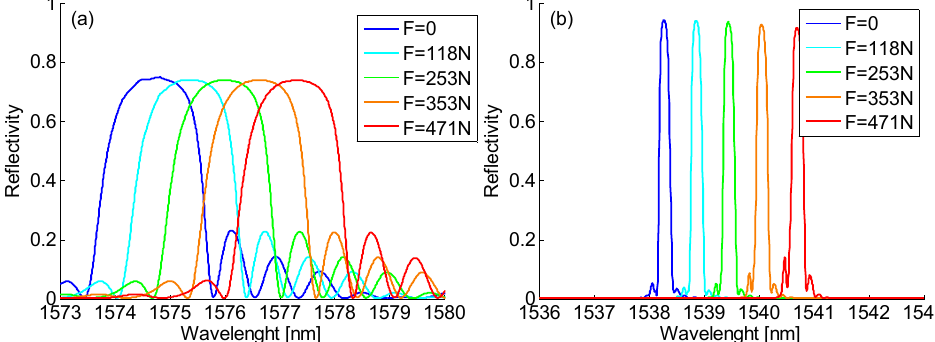
Figure 2. ( a ) Schematic view of the sensorized composite panel test; and ( b ) strain reading of two strain gauges (SGs) fixed by means of Attack and M-Bond 200 adhesive, respectively, for different load states.